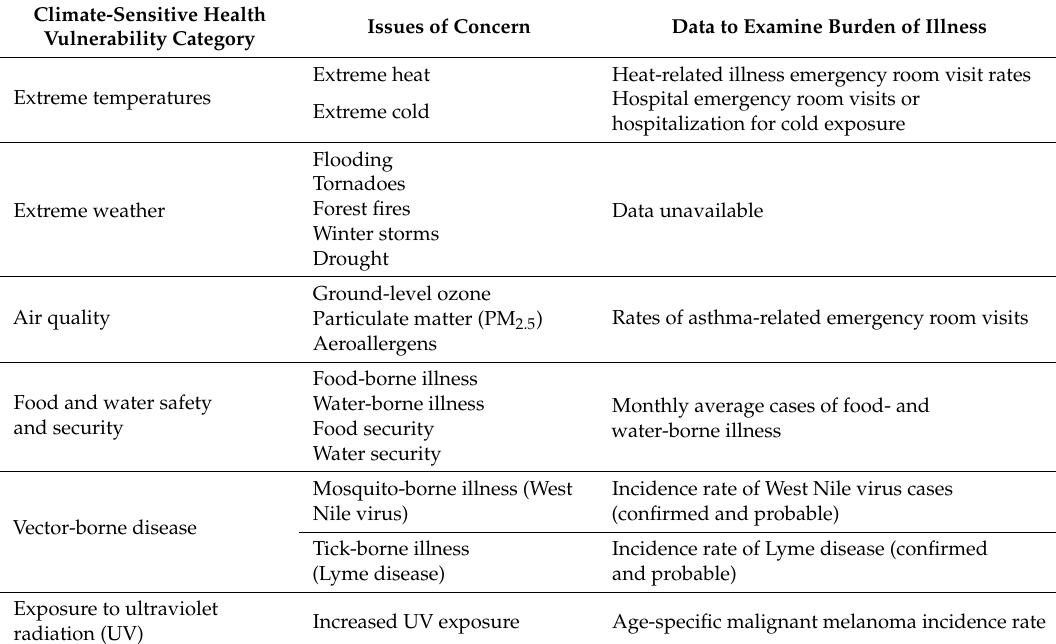
Table 1. Simcoe Muskoka climate-sensitive health vulnerabilities.